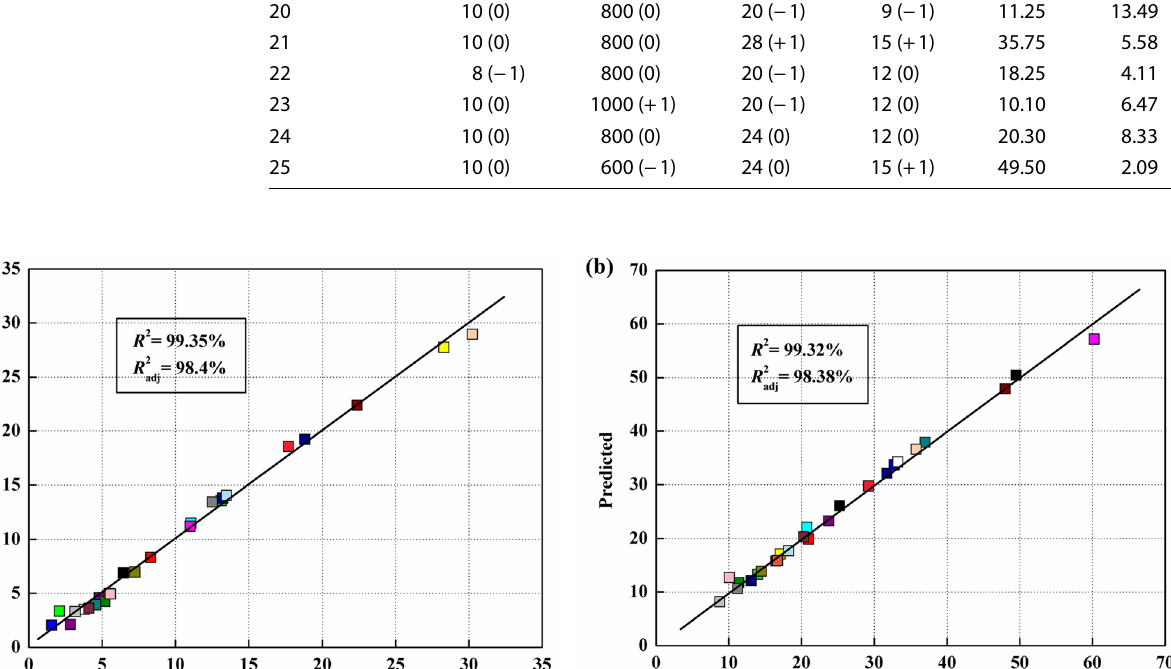
Fig. 5 Comparison of predicted and actual values for ( a ) t